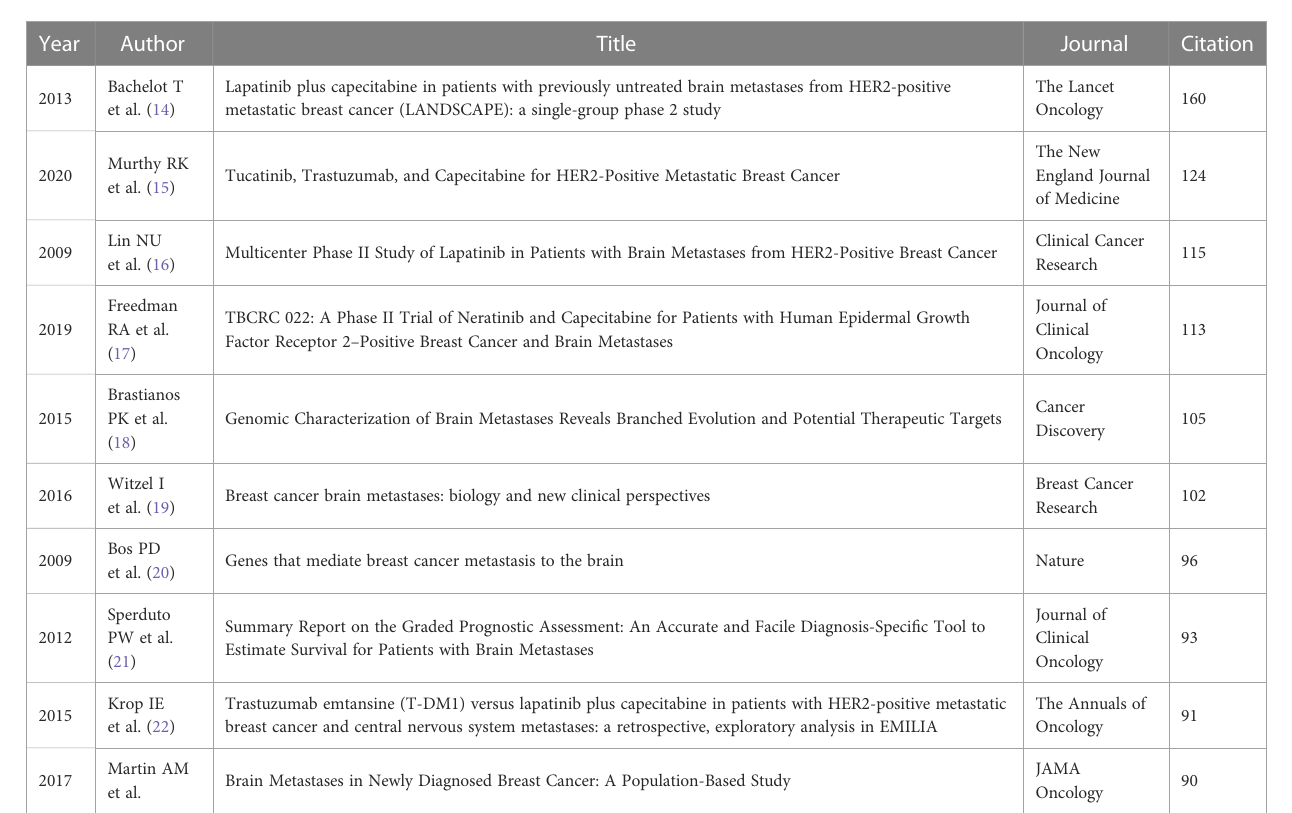
TABLE 5 Top 10 cocited